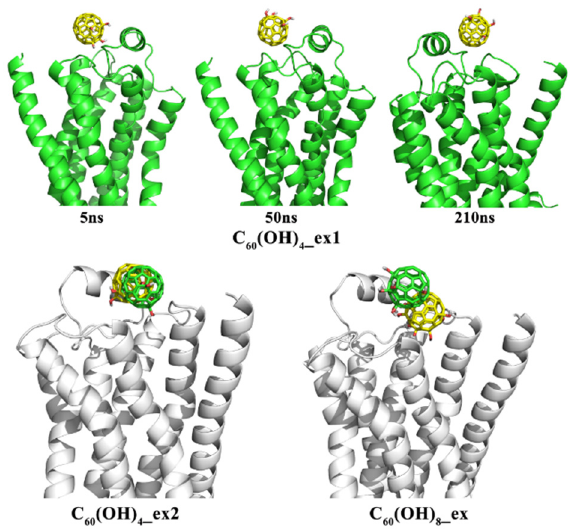
Figure 8. Three snapshots of C 60 (OH) 4 _ex1 at different simulation times are shown above, and the two systems C 60 (OH) 4 _ex2 and C 60 (OH) 8 are shown below. The green and yellow models of C 60 (OH) X (X = 4,8) represent initial and final positions, respectively.